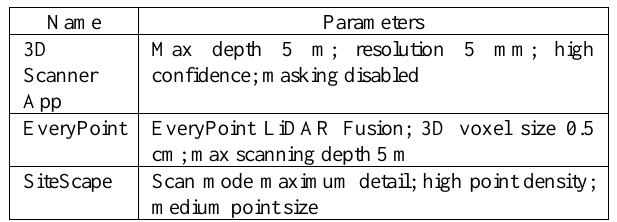
Table 1 . Parameters used in the LiDAR iPad application.